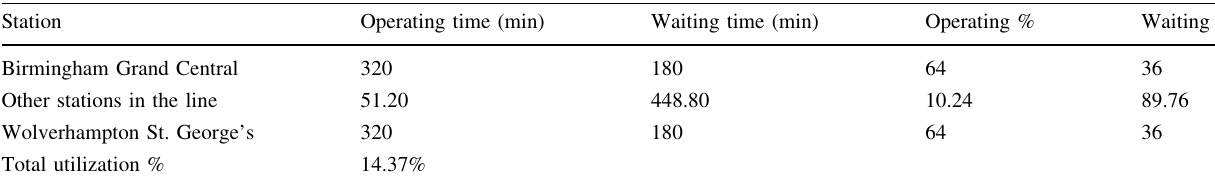
Table 10 Operating and waiting times of the rail system during off-peak hours in anticlockwise direction